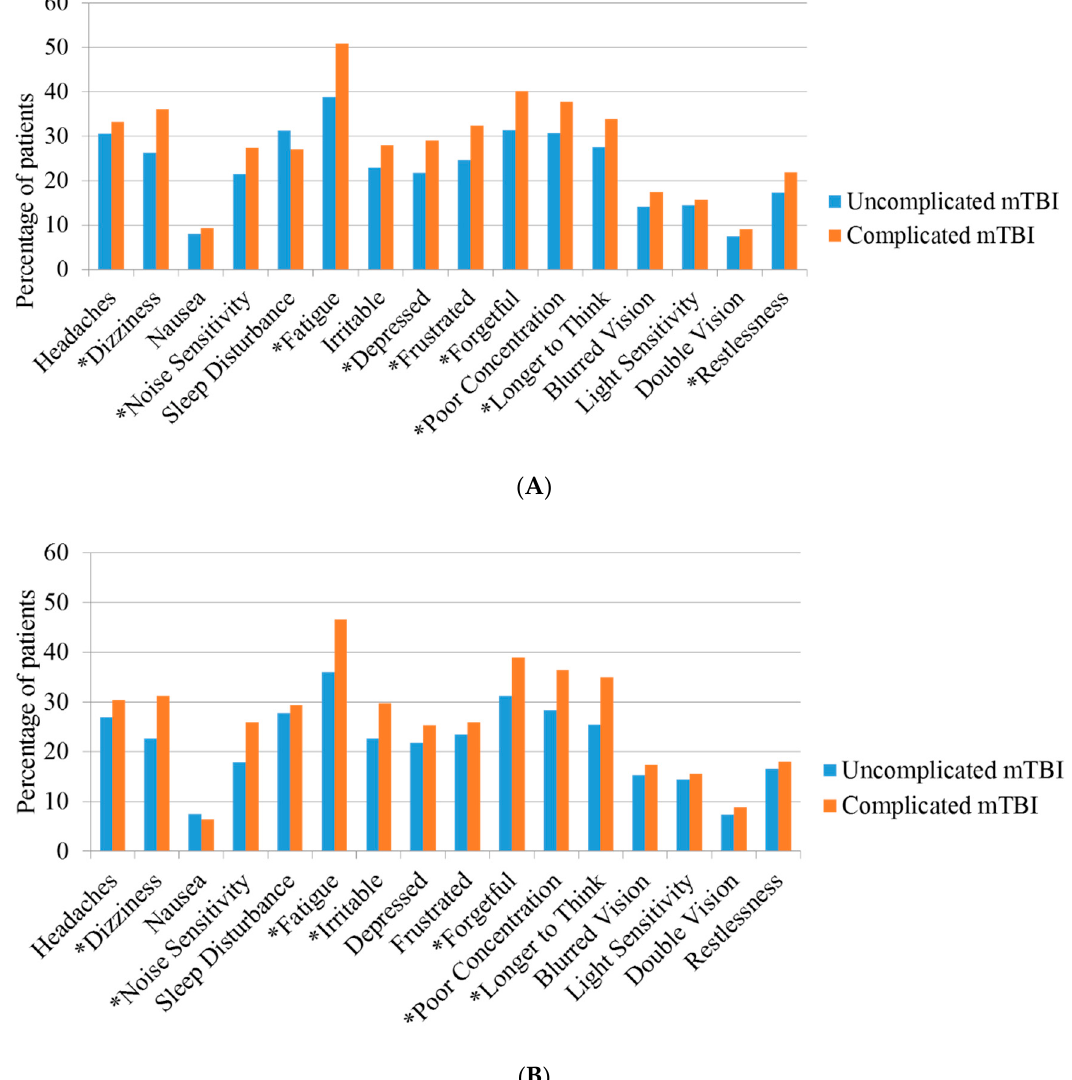
Figure 3. ( A ) Frequency of post-concussion symptoms with a severity rating of two (mild problem) or higher at 3 months. ( B ). Frequency of post-concussion symptoms with a severity rating of two (mild problem) or higher at 6 months. * significant ( p < 0.05).